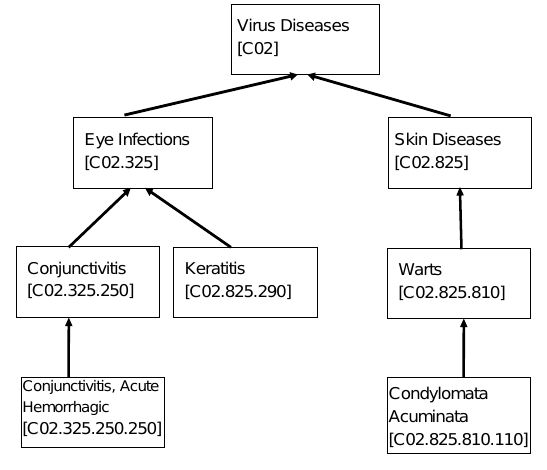
Fig. 3. A Segment of the MeSH Domain